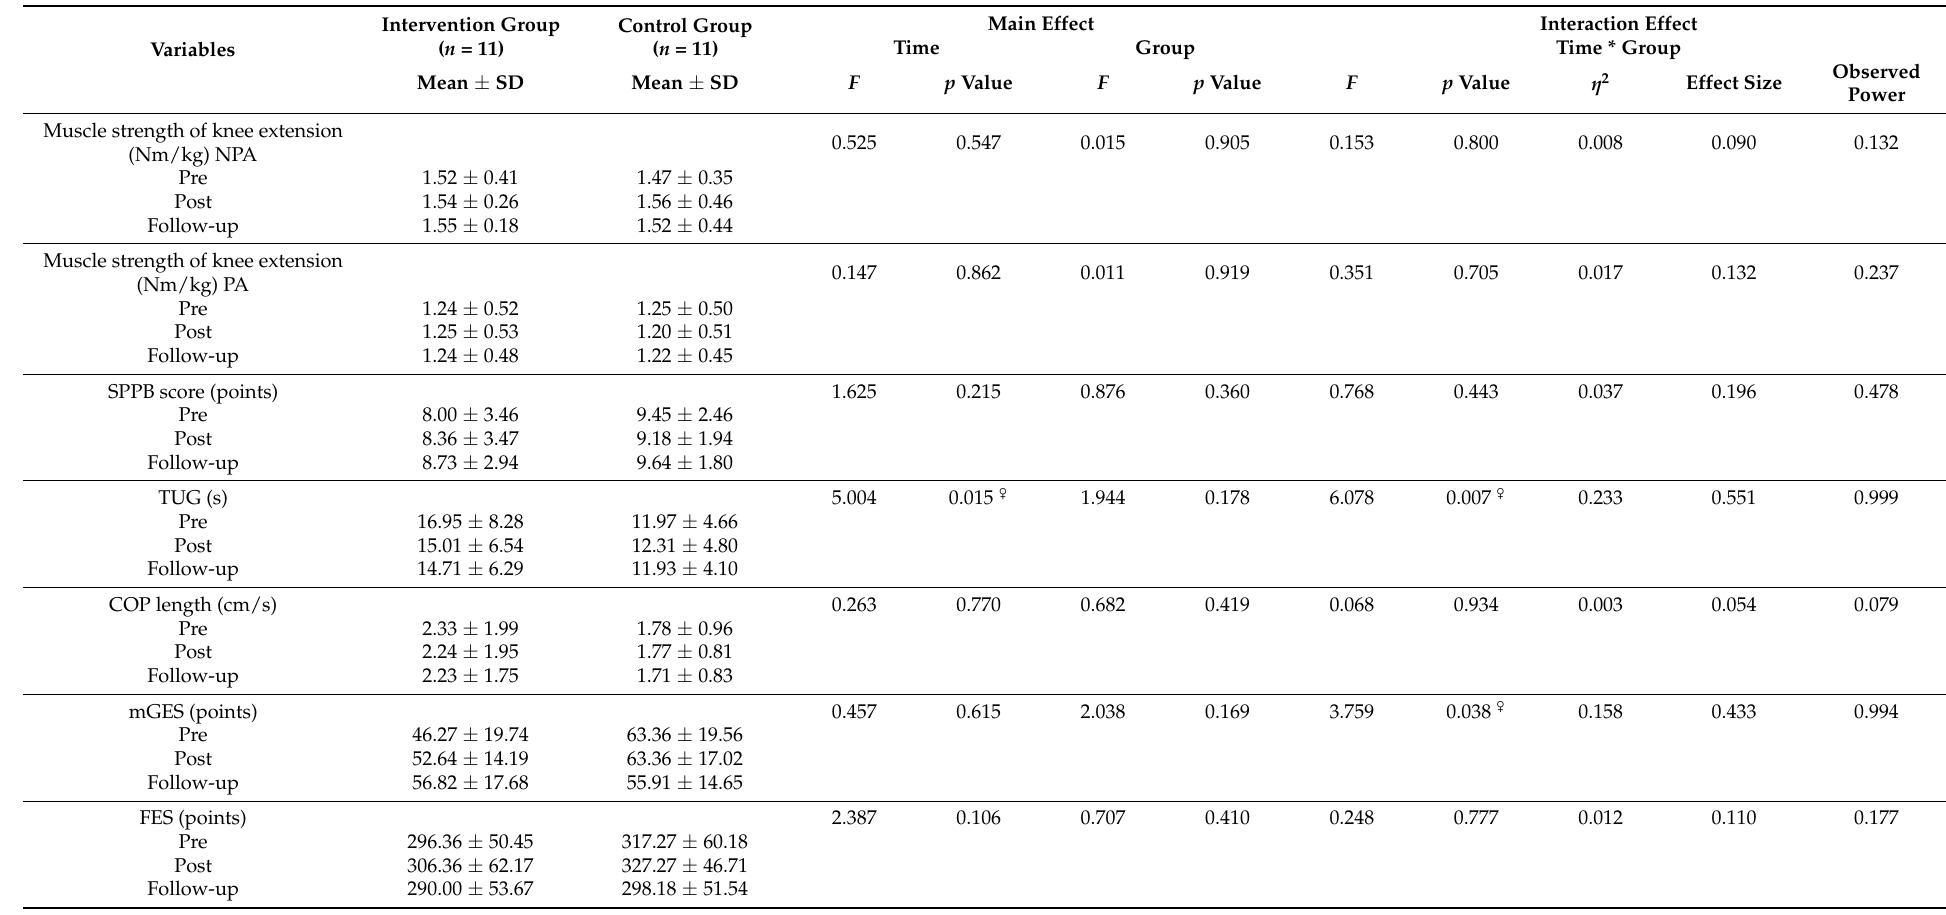
Table 2. Pre (0-week), post (6-week), and follow-up (10-week) outcome measures of each